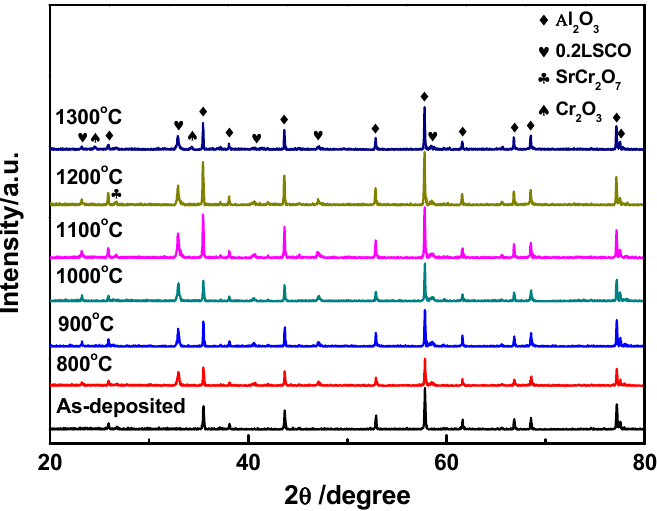
Figure 1. XRD patterns of 0.2LSCO thin films at different post-annealing